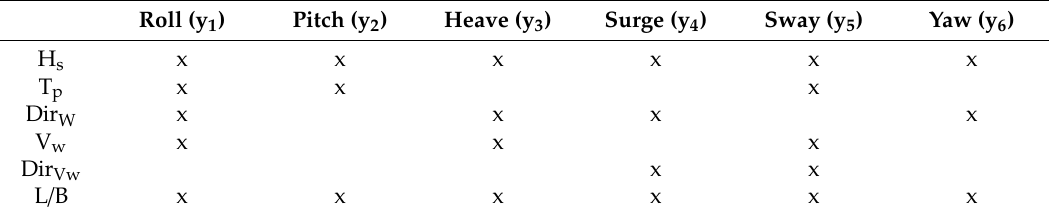
Table 8. Summary of the selected predictors for each response variable. Variables that have an e ff ect